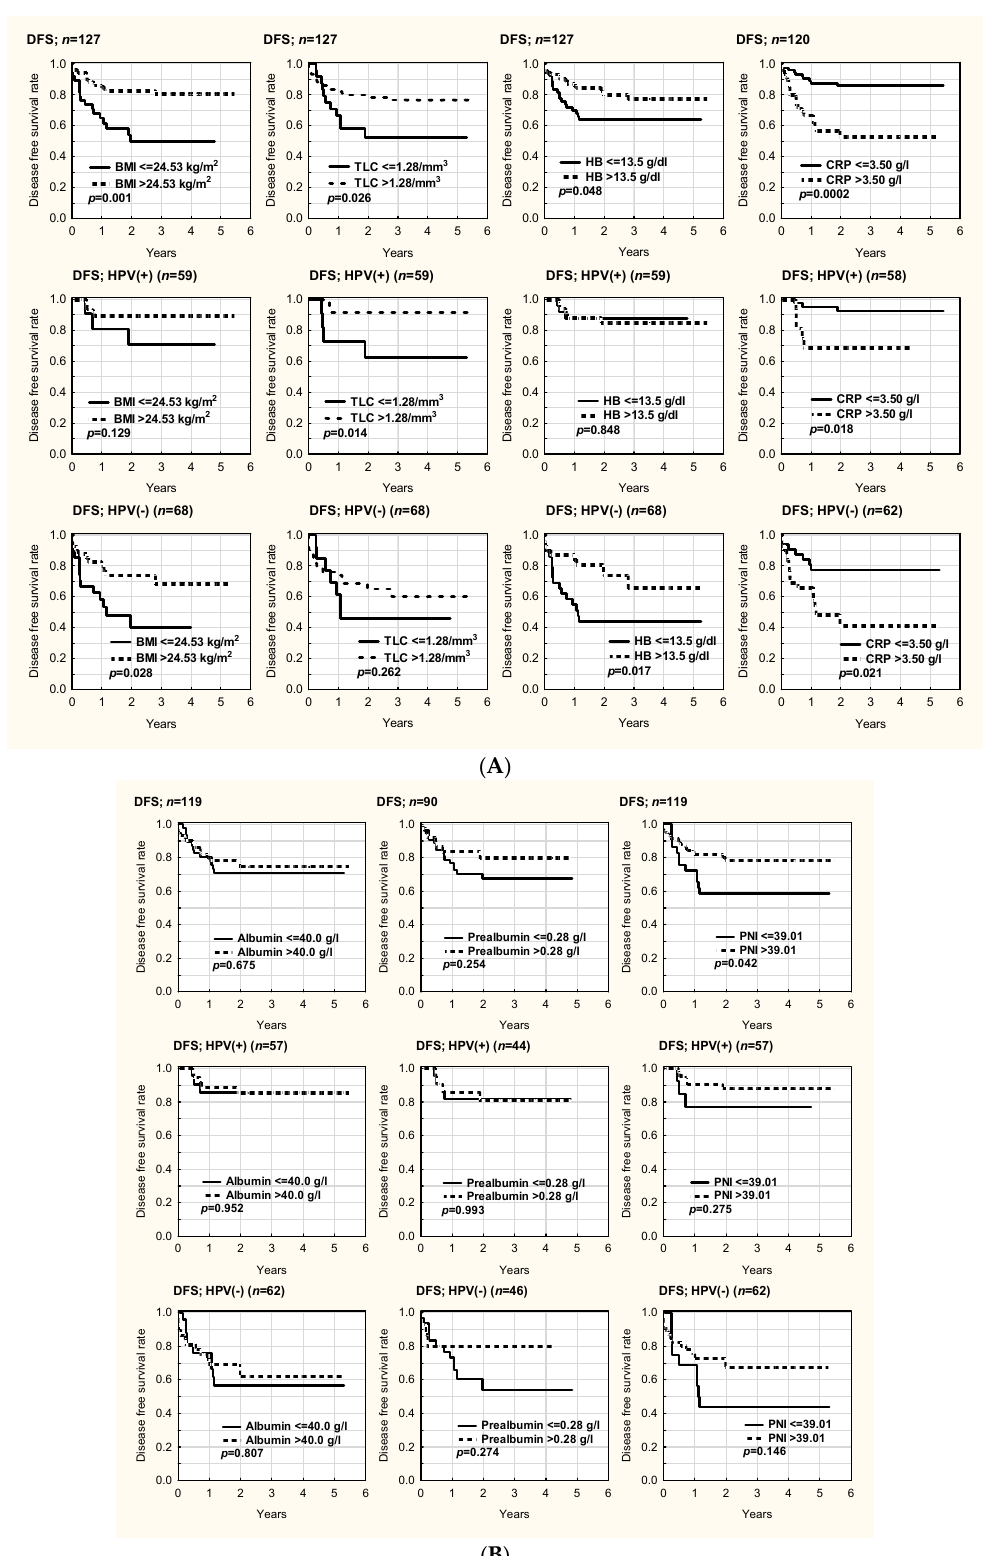
Figure 2. ( A ). Disease-free survival (DFS) in HPV-, HPV+, and all patients according to body mass index (BMI), total lymphocyte count (TLC), hemoglobin (HB) level, and C-reactive protein (CRP) level. ( B ). Disease-free survival (DFS) in HPV-, HPV+, and all patients according to albumin and prealbumin levels and prognostic nutritional index